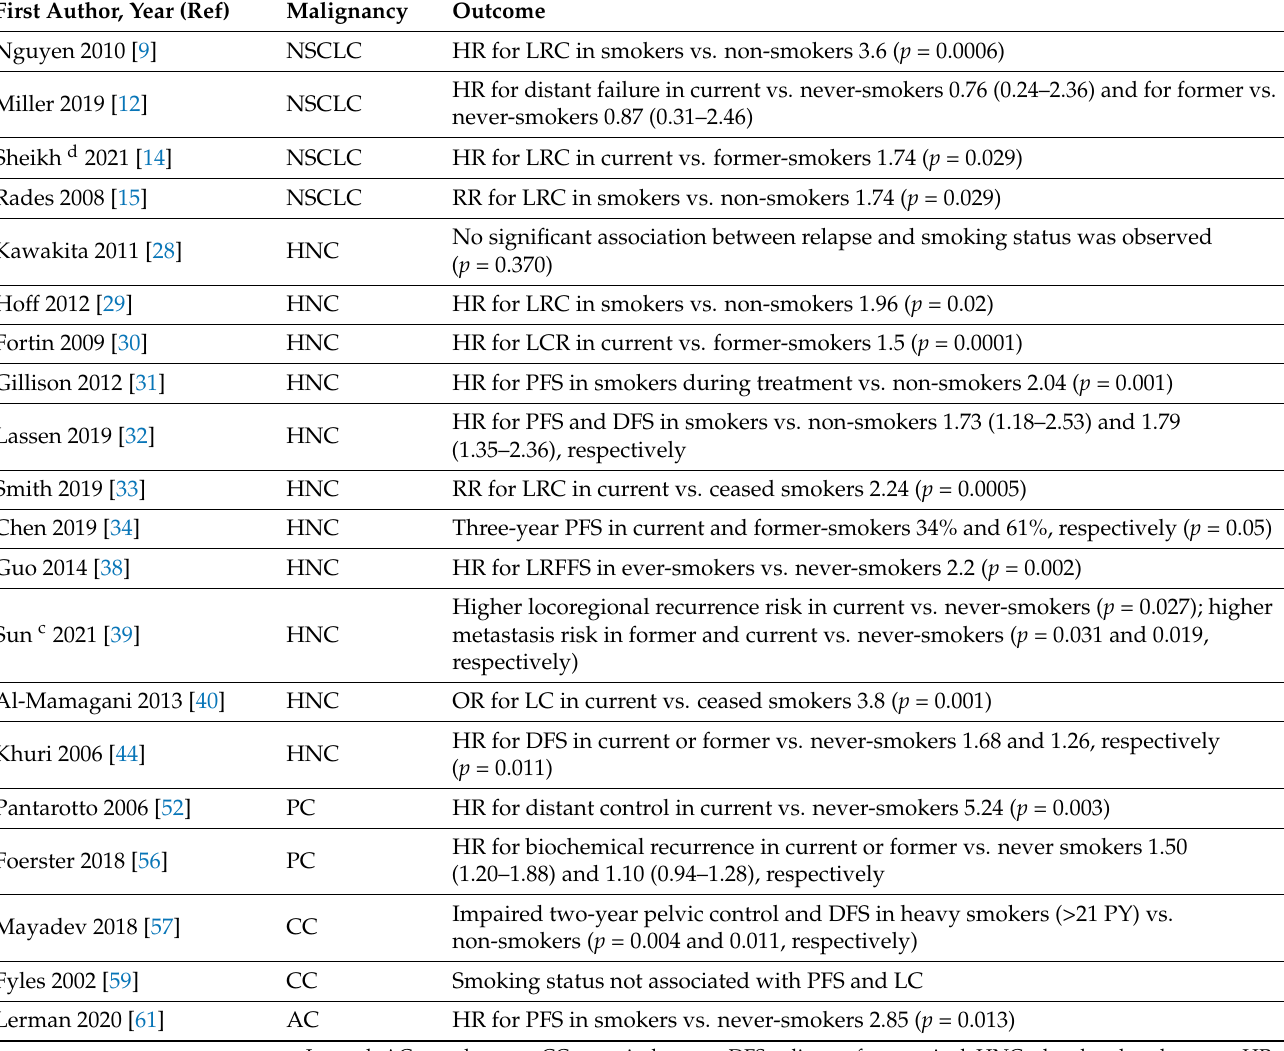
Table 3. Impact of tobacco smoking on locoregional and distant